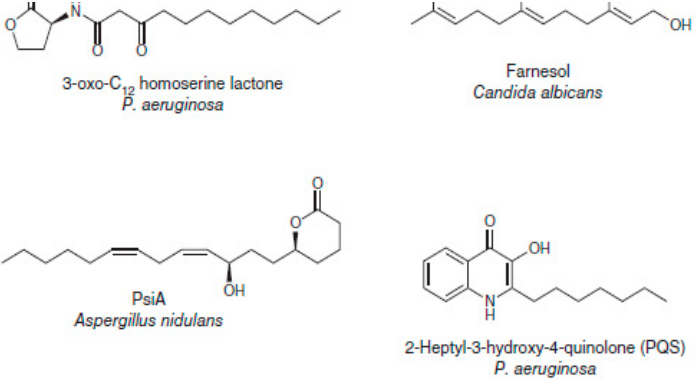
Figure 12. Examples of low-diversity molecules in the MDDR